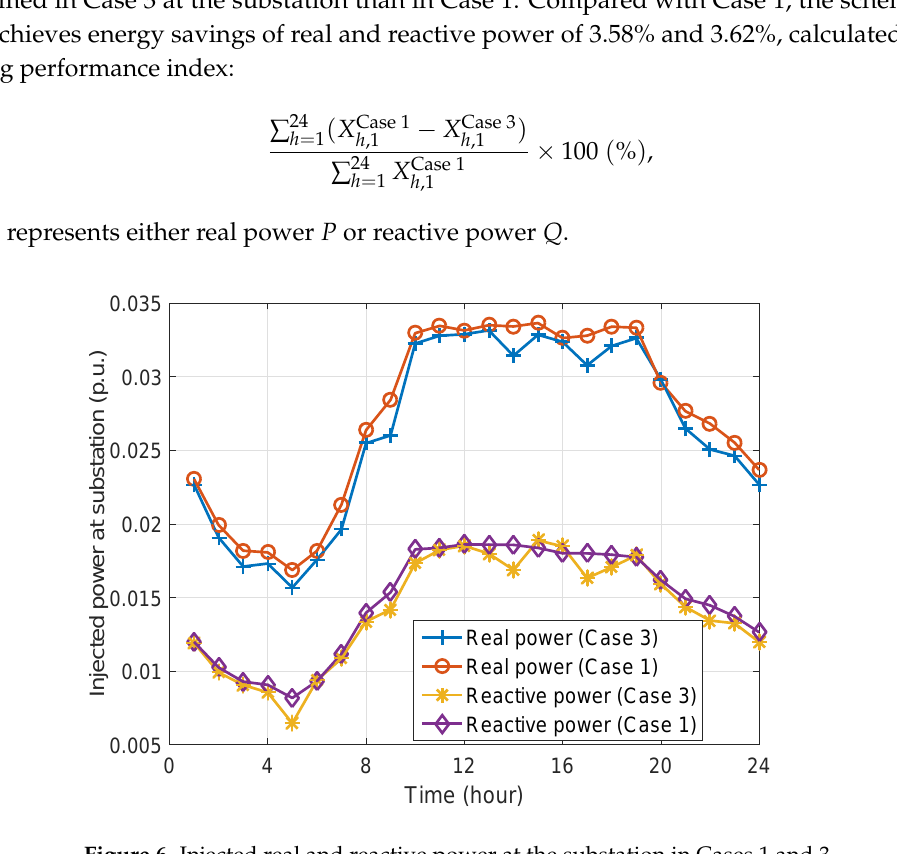
Figure 6. Injected real and reactive power at the substation in Cases 1 and